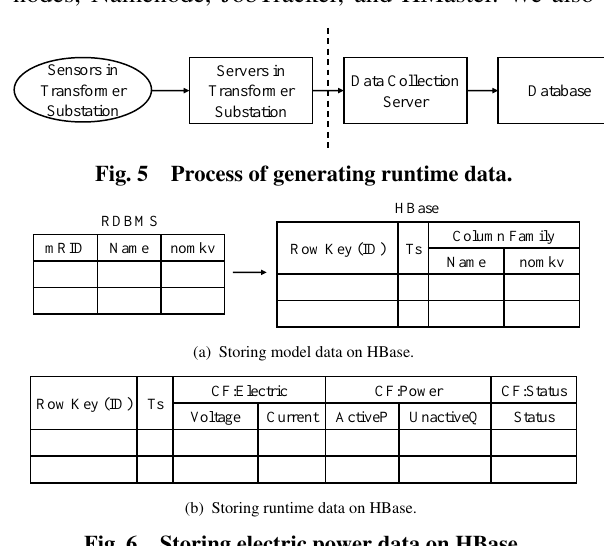
Fig. 6 Storing electric power data on